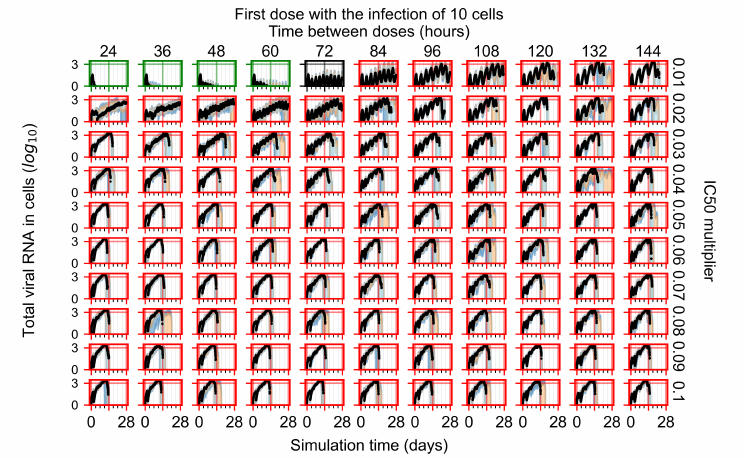
Figure A73. Amount of viral RNA in infected cells (arbitrary units), Y axis in log scale, and exponent values as tick